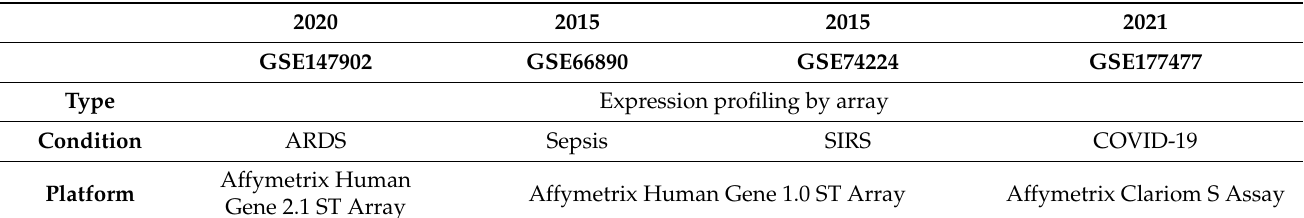
Table 1. Summary of NCBI GEO datasets utilized for WGCNA and module preservation